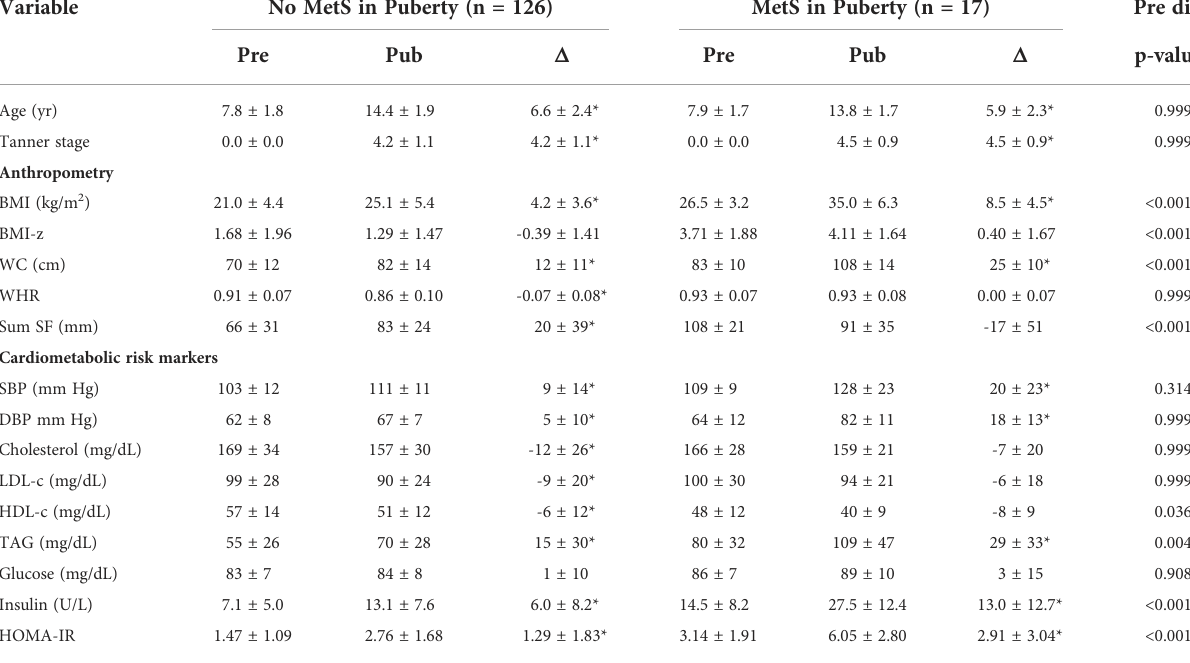
TABLE 3 Pre and pubertal levels and change of anthropometry and cardiometabolic risk markers grouped by the presence or absence of metabolic syndrome in puberty.